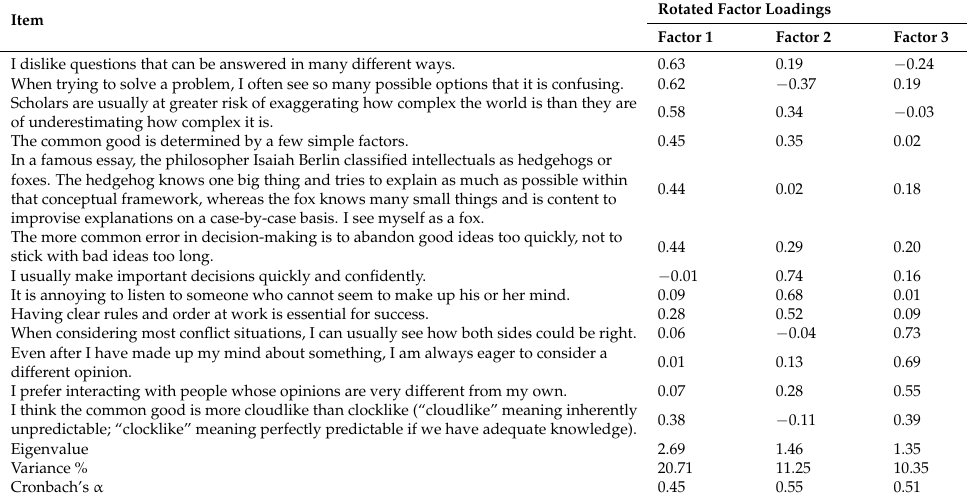
Table 1. Results of the Exploratory Factor Analysis for the Fox-Hedgehog Scale (adopted from Tetlock